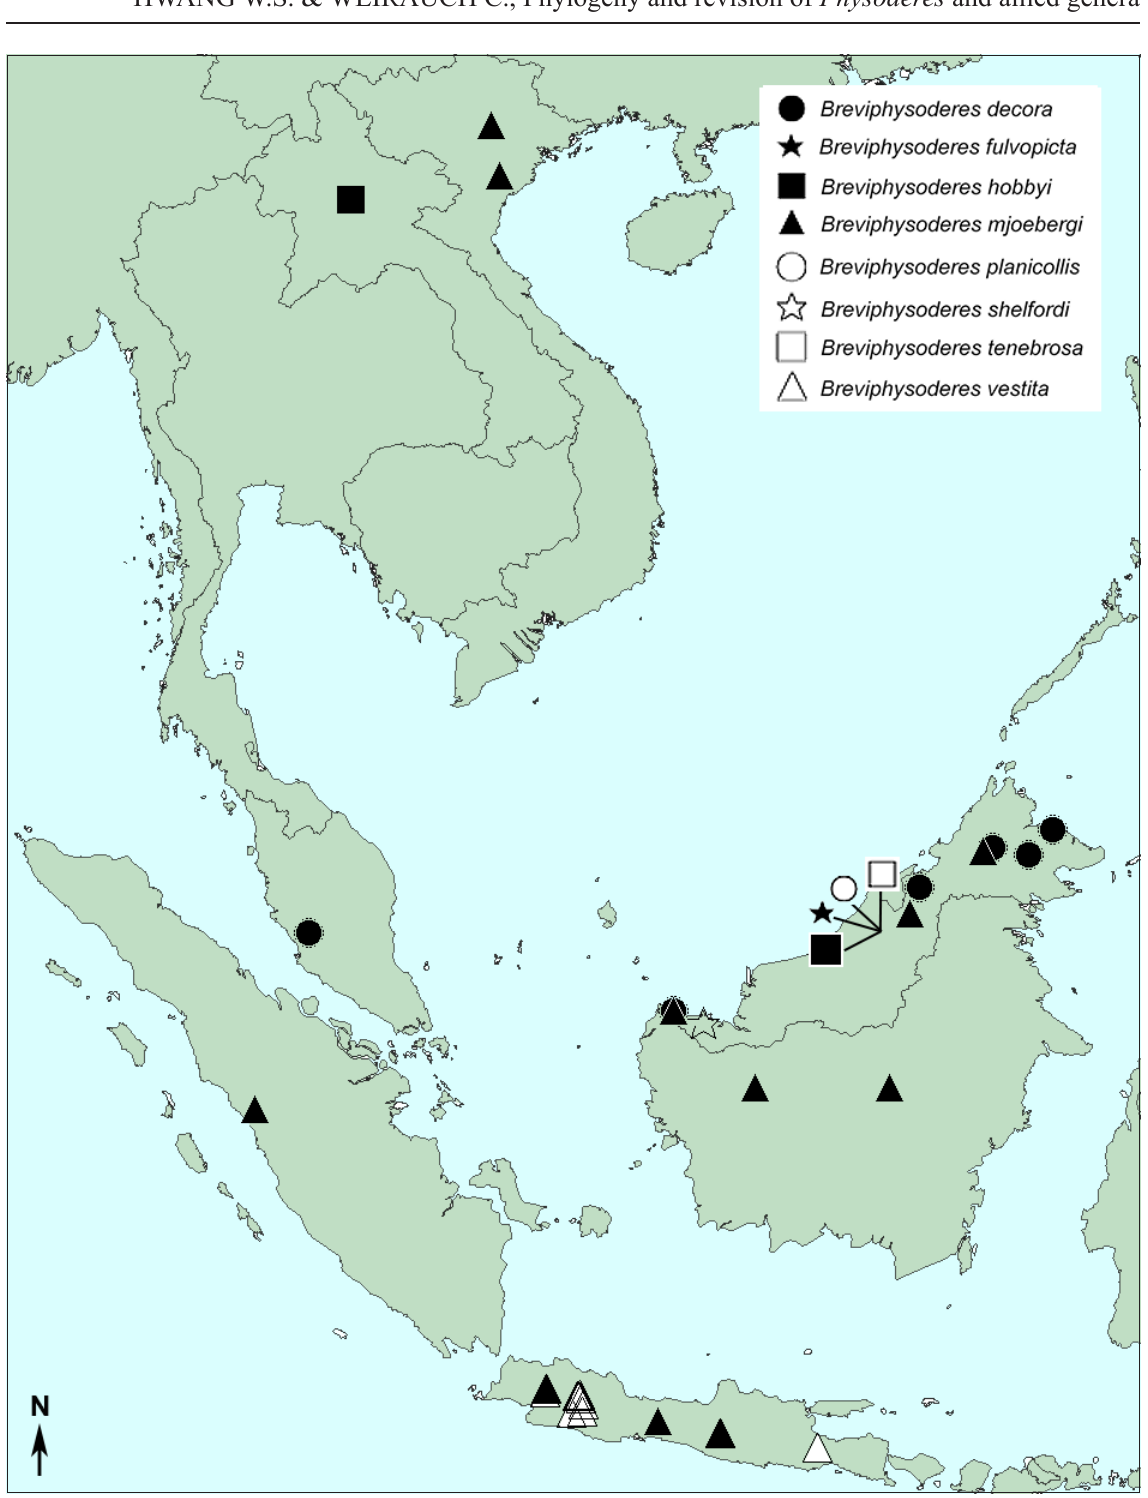
Fig. 6. Distribution map for species of Breviphysoderes gen.